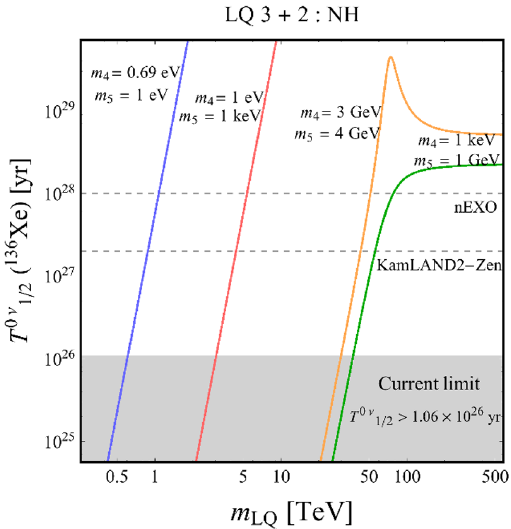
Figure 13 . T 0 (cid:23) ( 136 Xe) as a function of m LQ for 4 choices of m 4 and m 5 . The blue line corresponds 1 = 2 to m 4 = 0 : 69 eV and m 5 = 1 eV, the red line to m 4 = 1 eV and m 5 = 1 keV, the green line to m 4 = 1 keV and m 5 = 1 GeV, and the orange line to m 4 = 3 GeV and m 5 = 4 GeV. The same phases, mixing angles, and LECs as in section 8.2 were